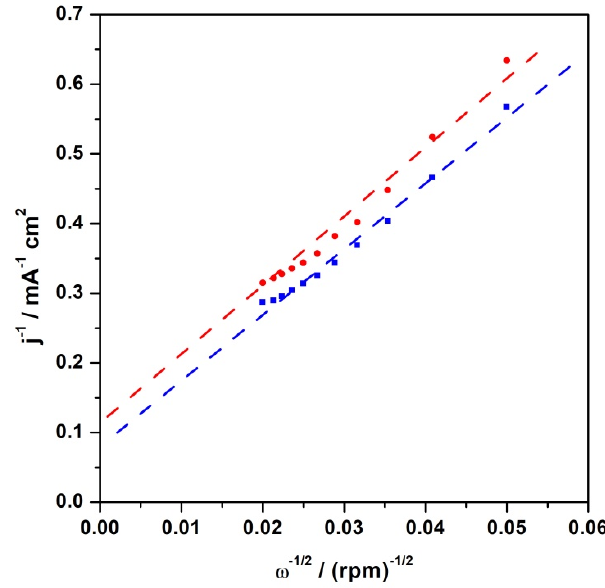
Figure 9. Koutecky–Levich reciprocal plots for electroreduction of oxygen (at 0.75 V) at CFeN@rGO- COOH with (blue curve) and without (red curve) external magnetic field.